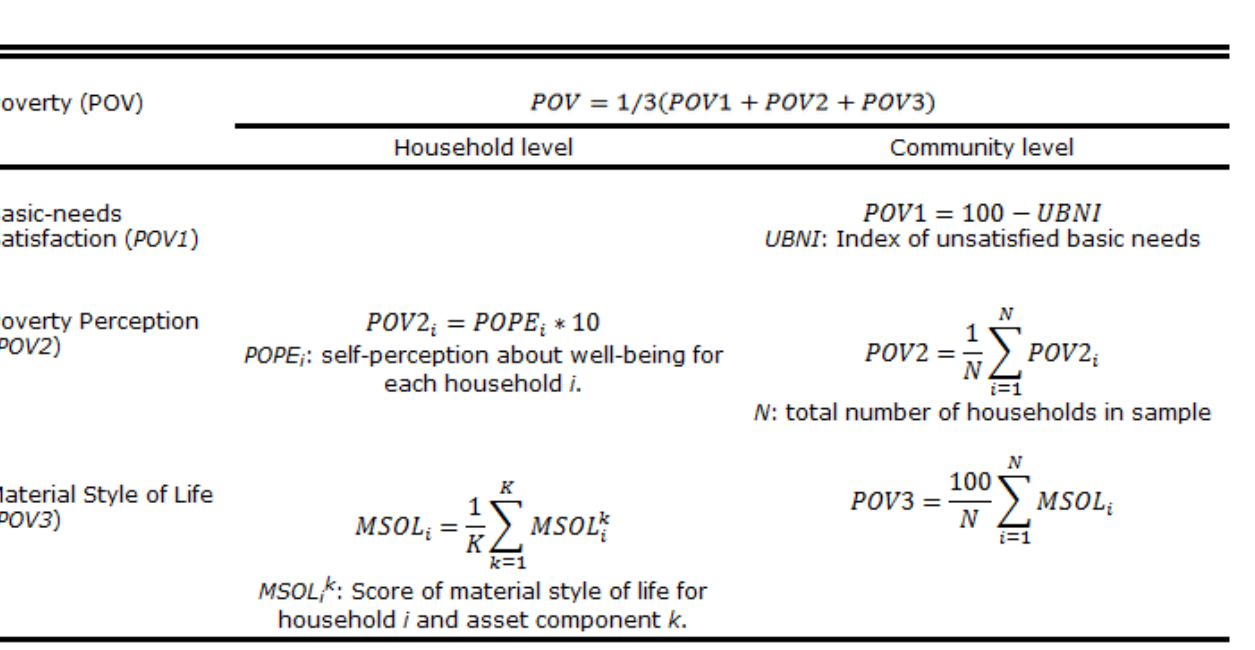
Table 2 . Calculation of poverty indicator and